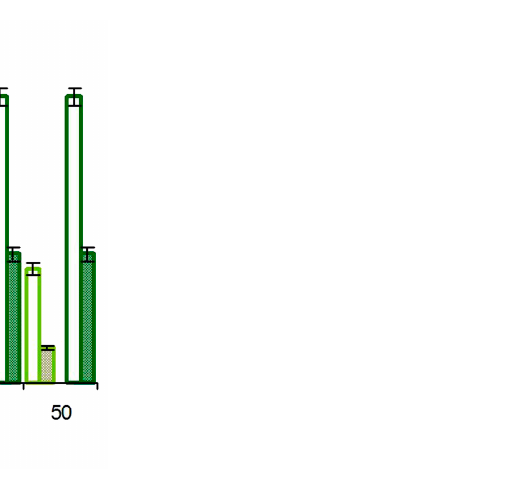
Figure 2. The effect of the amount of montmorillonite injected into the biomass and subsequent washing without stirring (without hatching) or with stirring at 30 rpm (hatching) on the weight gain of bicomponent samples.